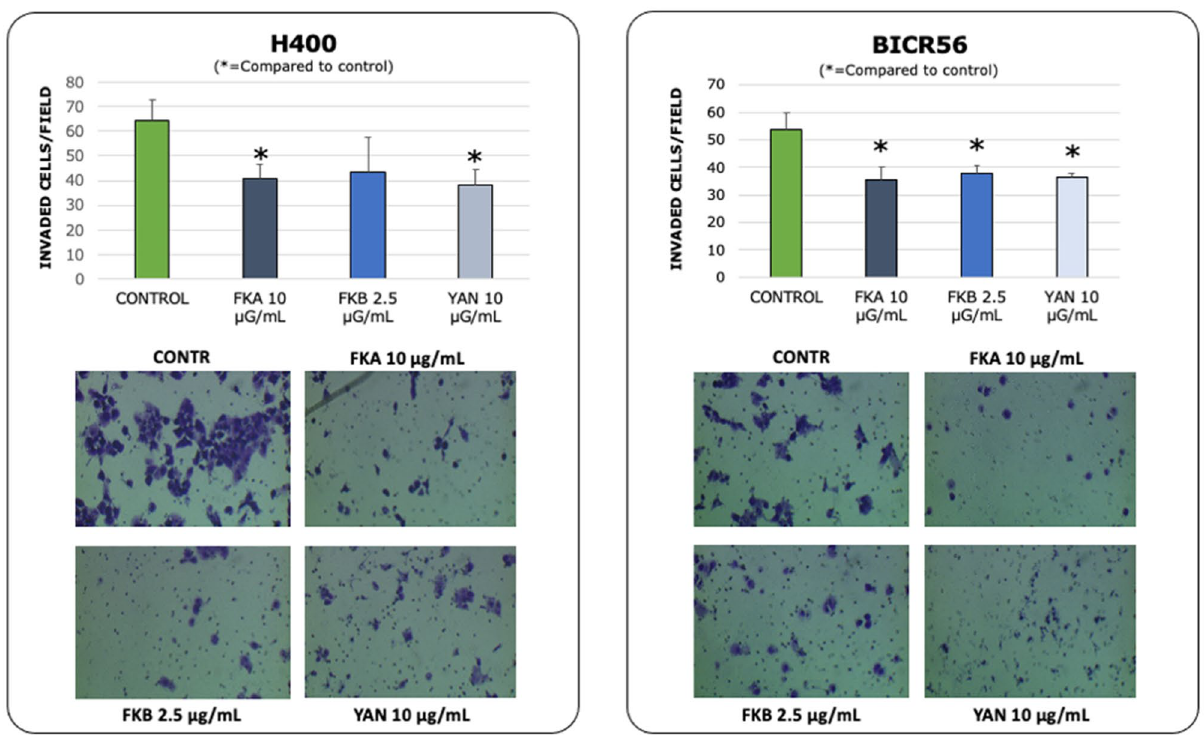
Figure 5. Invasion assays. invaded cell count of H400 and BICR56 cells incubated with 10 μg/ml FKA, 2.5 μg/ ml FKB and 10 μg/mL yangonin. Images were taken after 22 h at × 20 magnification (optical white light microscopy) showing fewer invading cells for treated groups compared to the control (representative fields). Graphs show quantification of invasion assays. The results were representative of 3 independent experiments. Data are represented as mean ± SD. Statistical significance is given as follows: * p < 0.05; compared to control group.